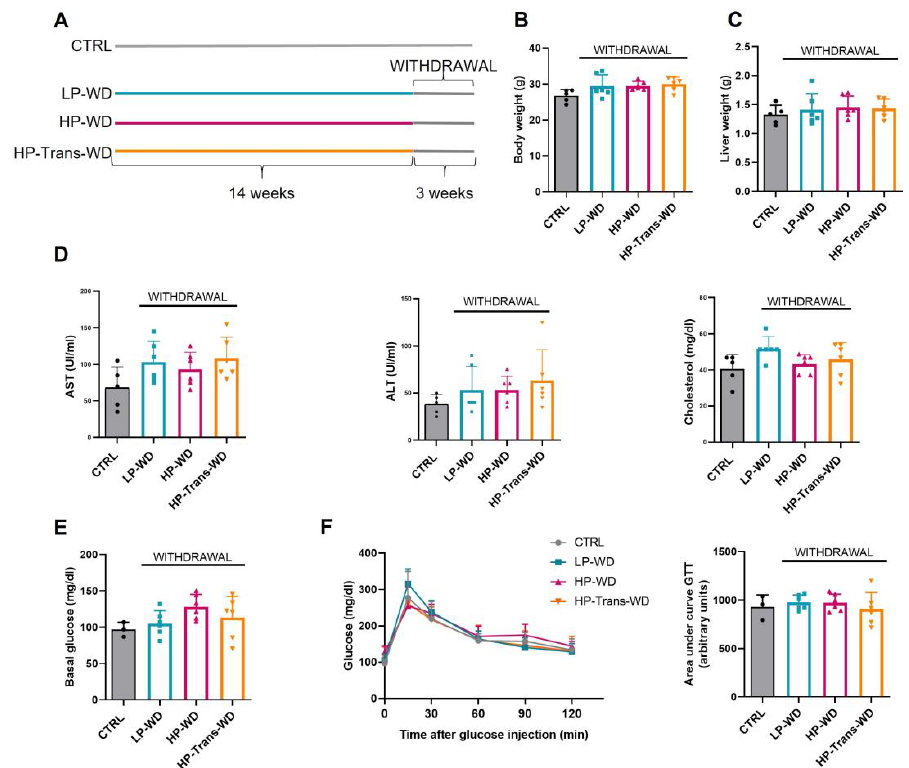
Figure 6. Effects of WD withdrawal on MS. ( A ) Mice were fed for 14 weeks with WD followed by 3 weeks of withdrawing. Effects of WD withdrawal: ( B ) Body and ( C ) Liver weight (n = 5–6). ( D ) AST, ALT, Cholesterol in serum after 12 h of fasting (n = 3–5). ( E ) Basal glucose levels in blood after 12 h of fasting. ( F ) Left: GTT curve after the period of withdrawal. Right: Area under the curve GTT (arbitrary units) (n = 3 – 6).